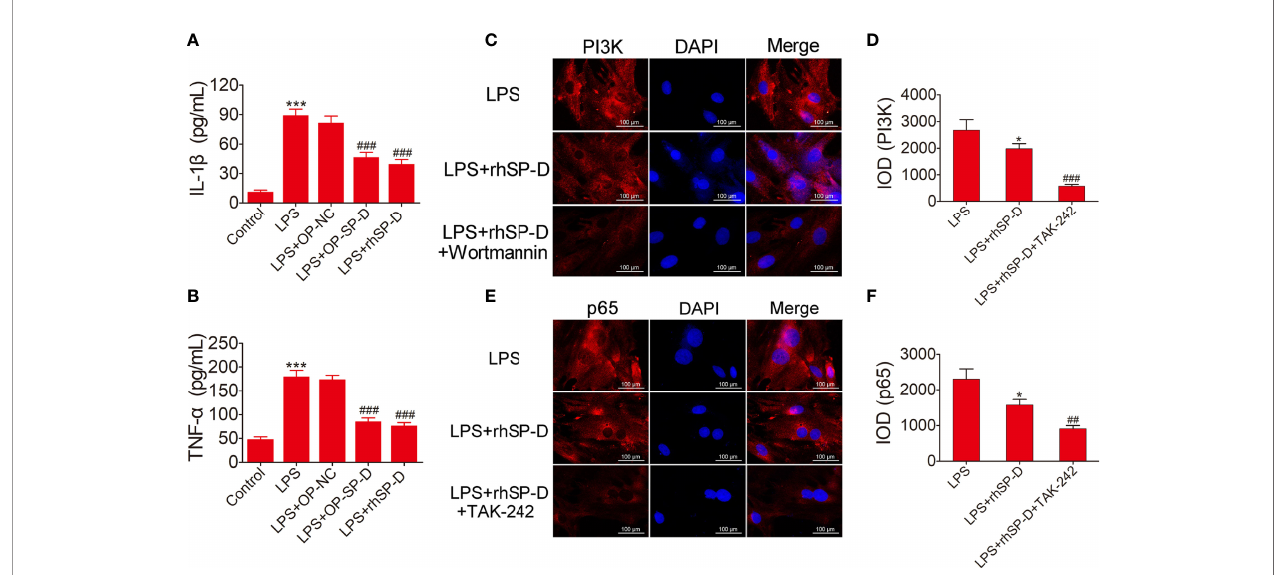
FIGURE 8 | Suppression of in fl ammatory response and the PI3K and NF- k B pathways by SP-D treatment in vitro . (A, B) Chondrocytes were pre-incubated with rhSP-D and transfection of pcDNA3.1-SP-D plasmid for 2 h before LPS co-treatment for 24 h. The concentrations of IL-1 b and TNF- a were determined by ELISA. Data were expressed as mean ± SEM (n = 3). ***P < 0.001 vs. control group; ### P < 0.001 vs. LPS group. (C – F) Immuno fl uorescence with antibodies to PI3K and p65 in chondrocytes, and the fl uorescence images of PI3K and p65-Tracker Red in chondrocytes. The IOD was quanti fi ed according to immuno fl uorescence. Data were expressed as mean ± SEM (n = 3). *P < 0.05 vs. LPS group; ## P < 0.01 and ### P < 0.001 vs. LPS + rhSP-D